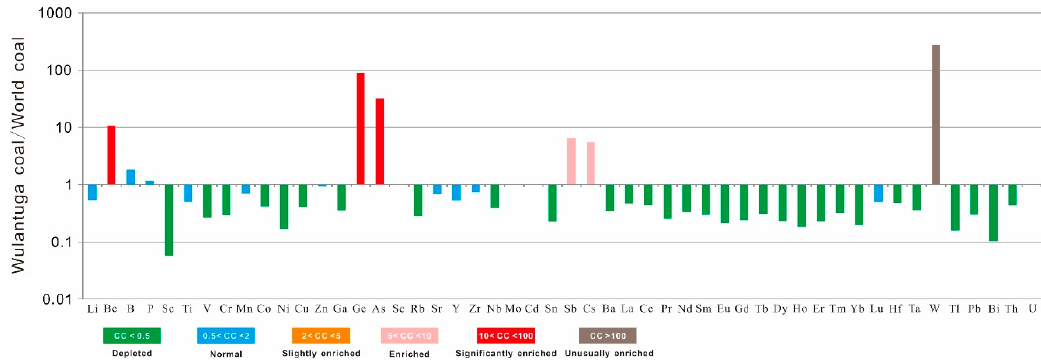
Figure 9. Concentration coefficients (CC) of trace elements in the high Ge Wulantuga coal vs. the world coal (the average concentration of trace elements from world coal reported by Ketris and Yudovich [68]). Table 5. Elemental affinities deduced from calculation of Pearson’s correlation coefficients between the content of each element in coal samples (not in trunks and glutenite samples) and ash yield or selected elements. Correlation Coefficients between Selected Elements or Ash Yield